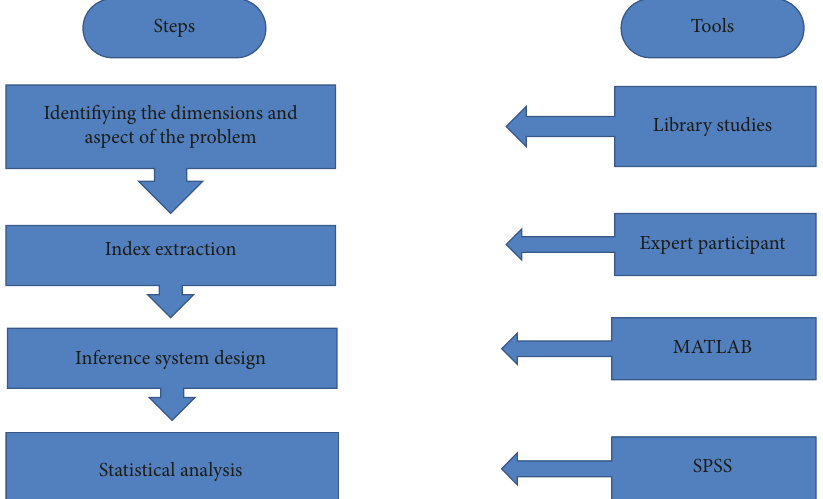
Figure 1: Research methodology